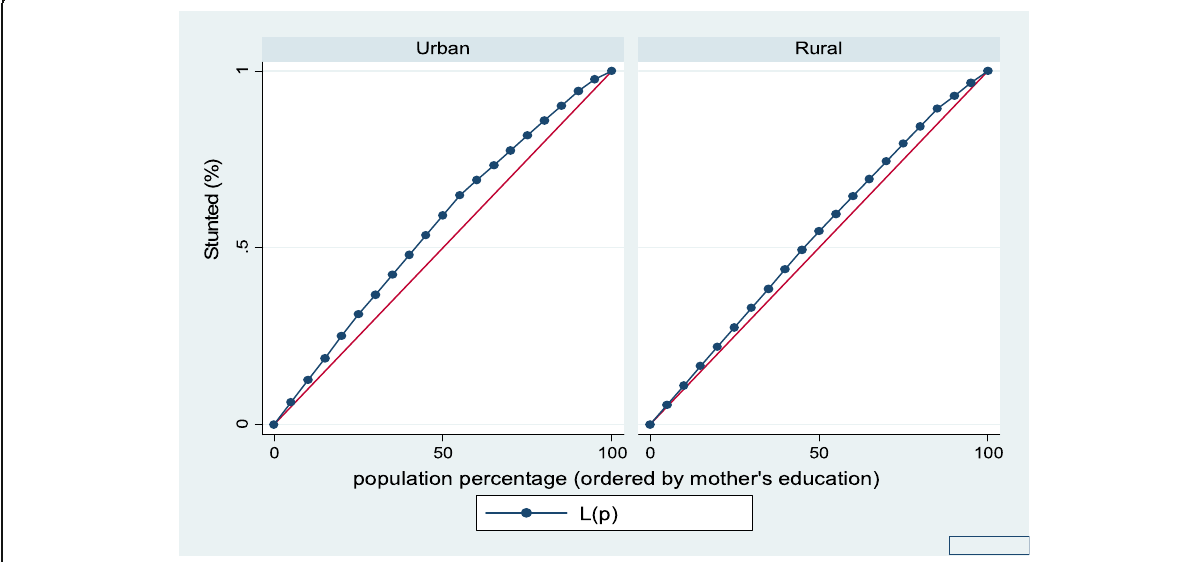
Fig. 7 Urban-rural Lorenz curve for stunting